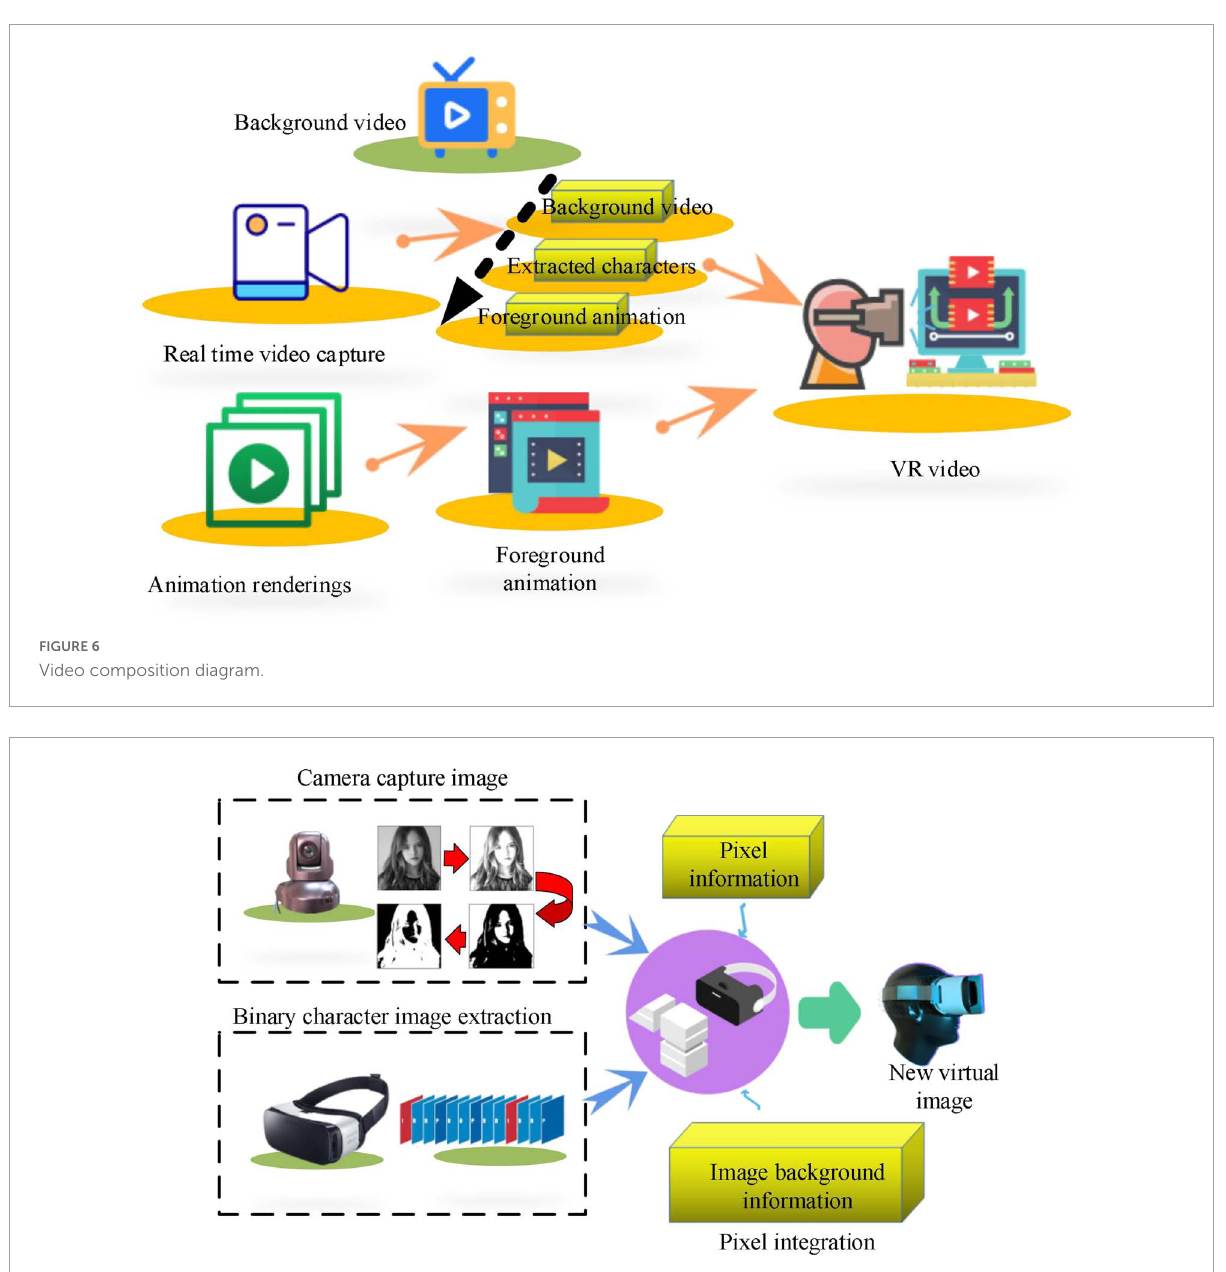
FIGURE7 Image synthesis process.